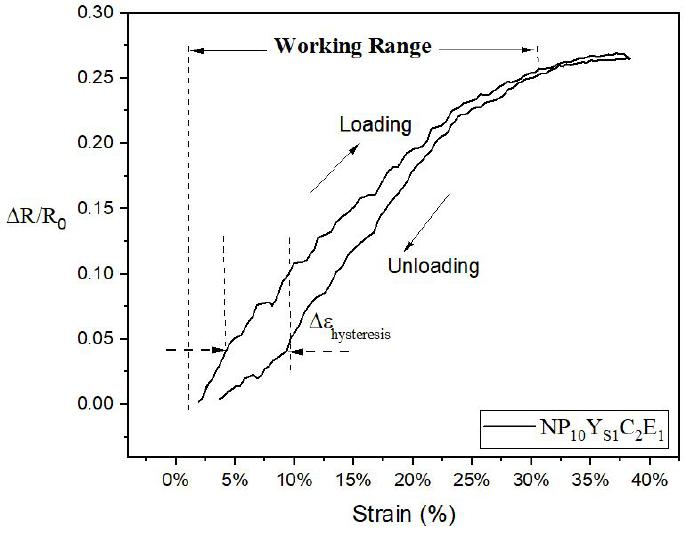
Figure 4. Relative resistance change versus strain plot of knitted strain sensor type NP 10 Y S